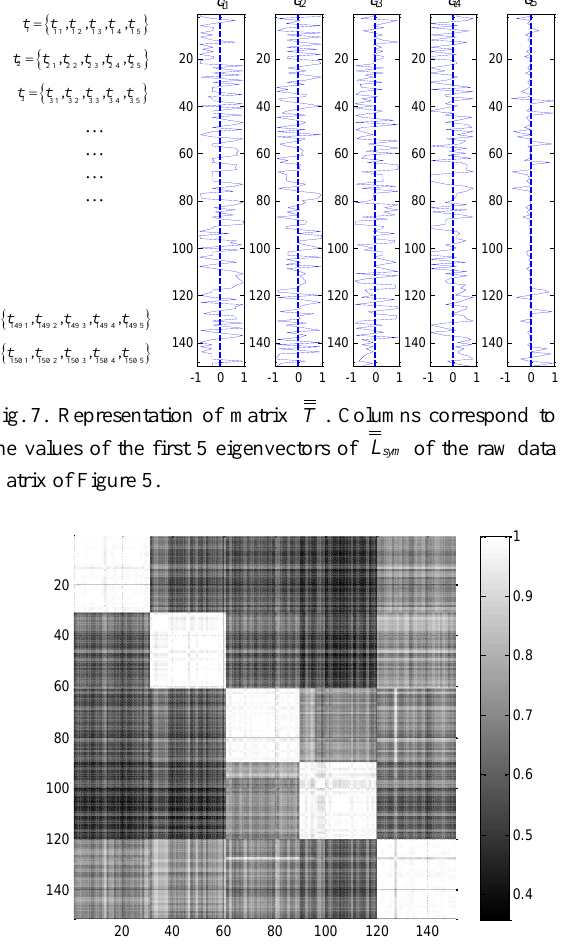
Fig. 8. Shuffled matrix containing checkboard clusters of